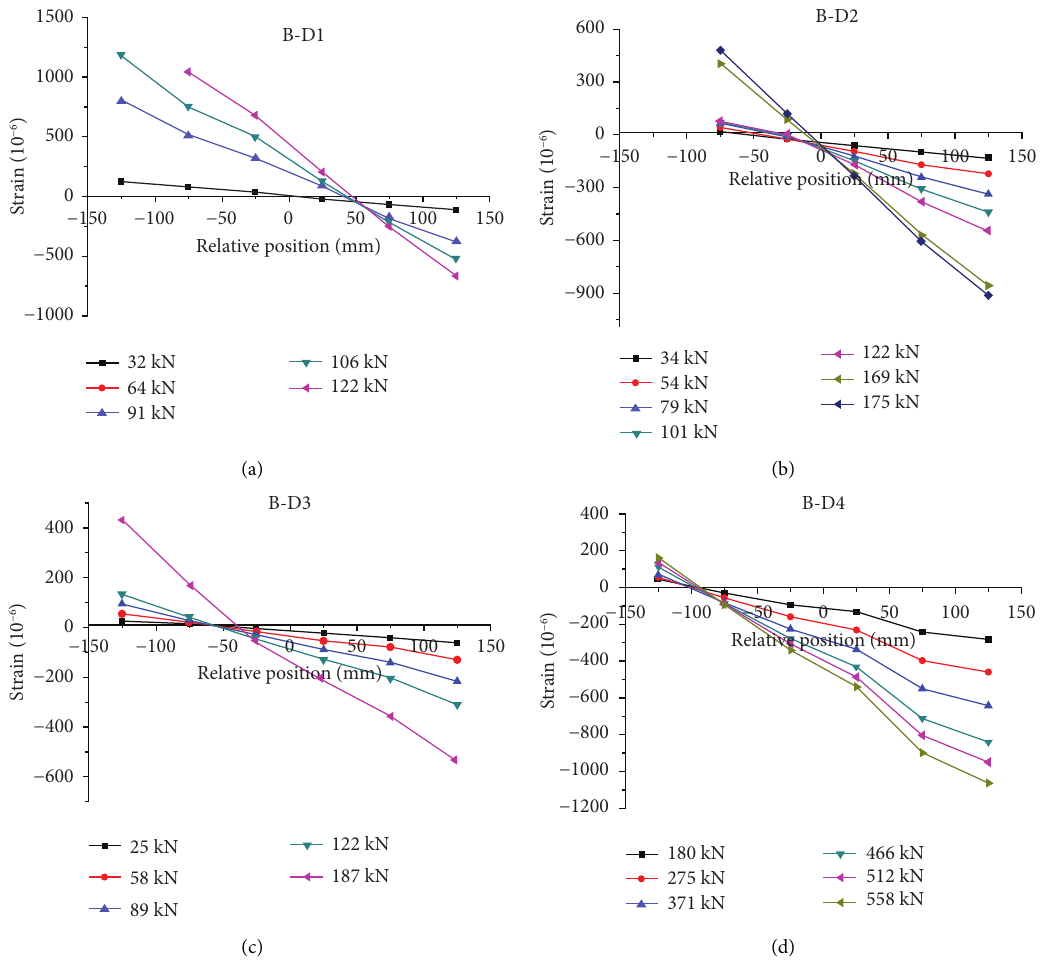
Figure 11: Strain-load relationship diagram of concrete. Table 5: Mechanical properties of stainless steel bars.